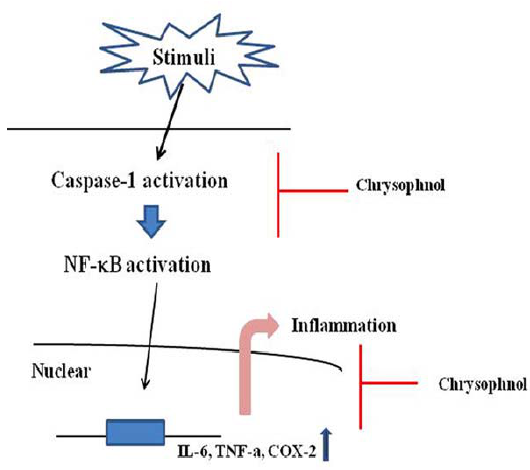
Figure 6. Proposed anti-inflammatory mechanism of chrysophanol in LPS-stimulated mouse peritoneal